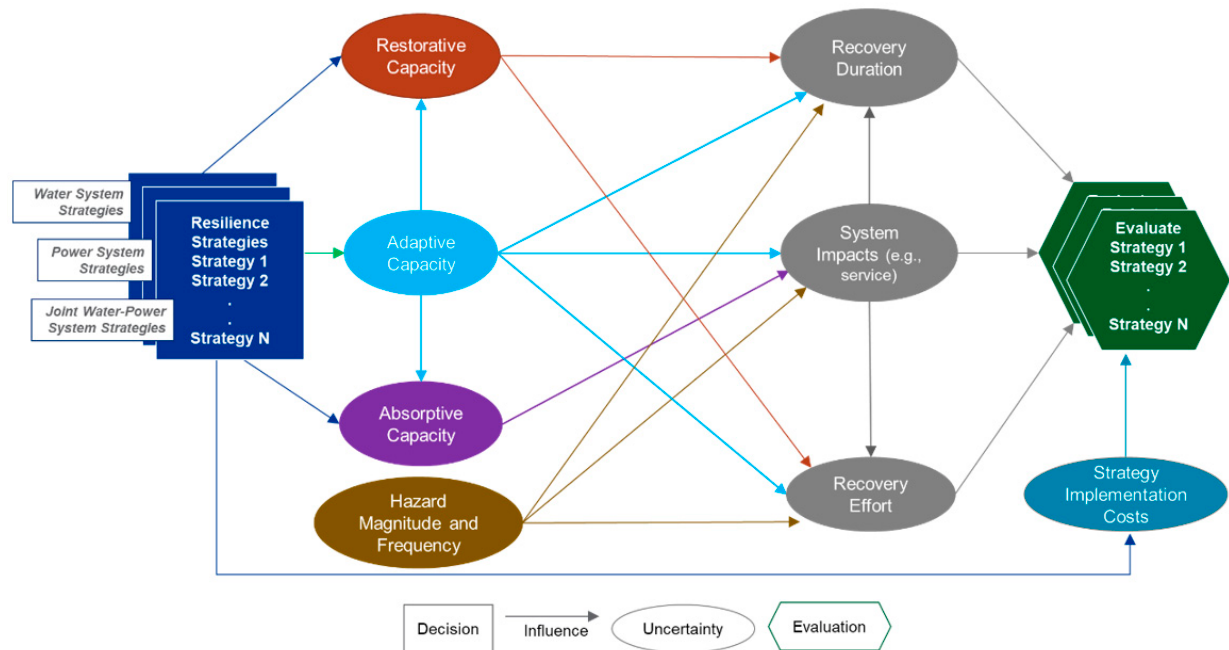
Figure 5. Influence diagram of conceptual WPS resilience